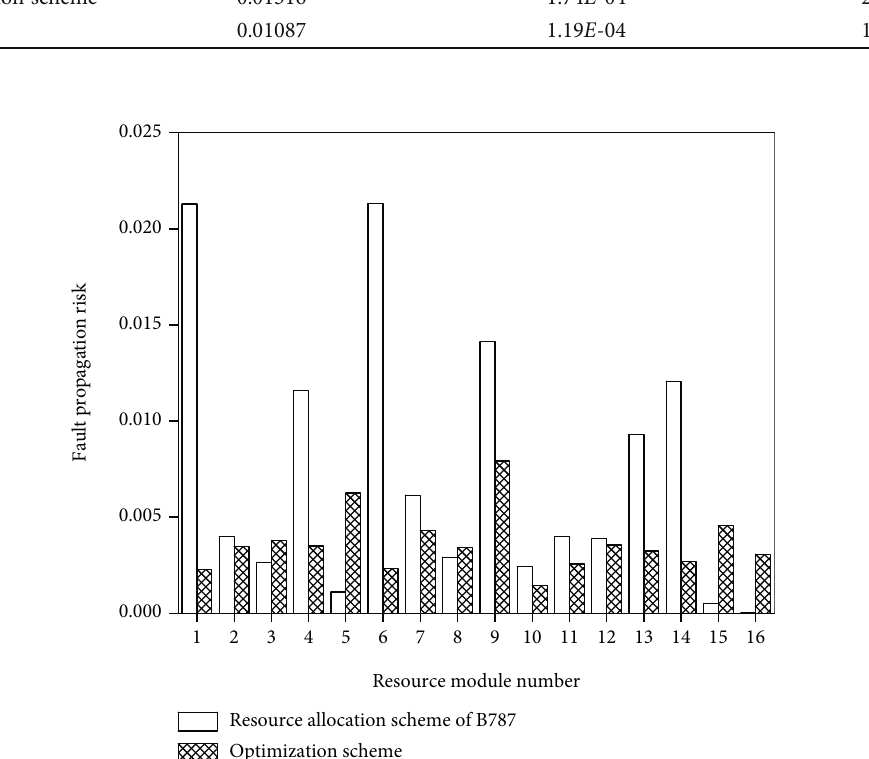
Figure 6: Fault propagation risk of di ff erent resource allocation schemes.